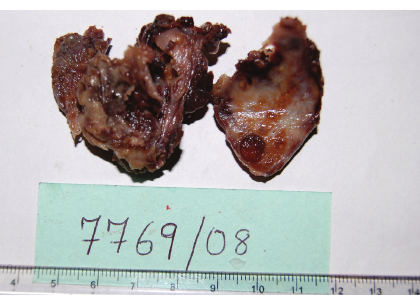
Figure 3: HPE specimen showing the abscess cavity in the right lobe of the